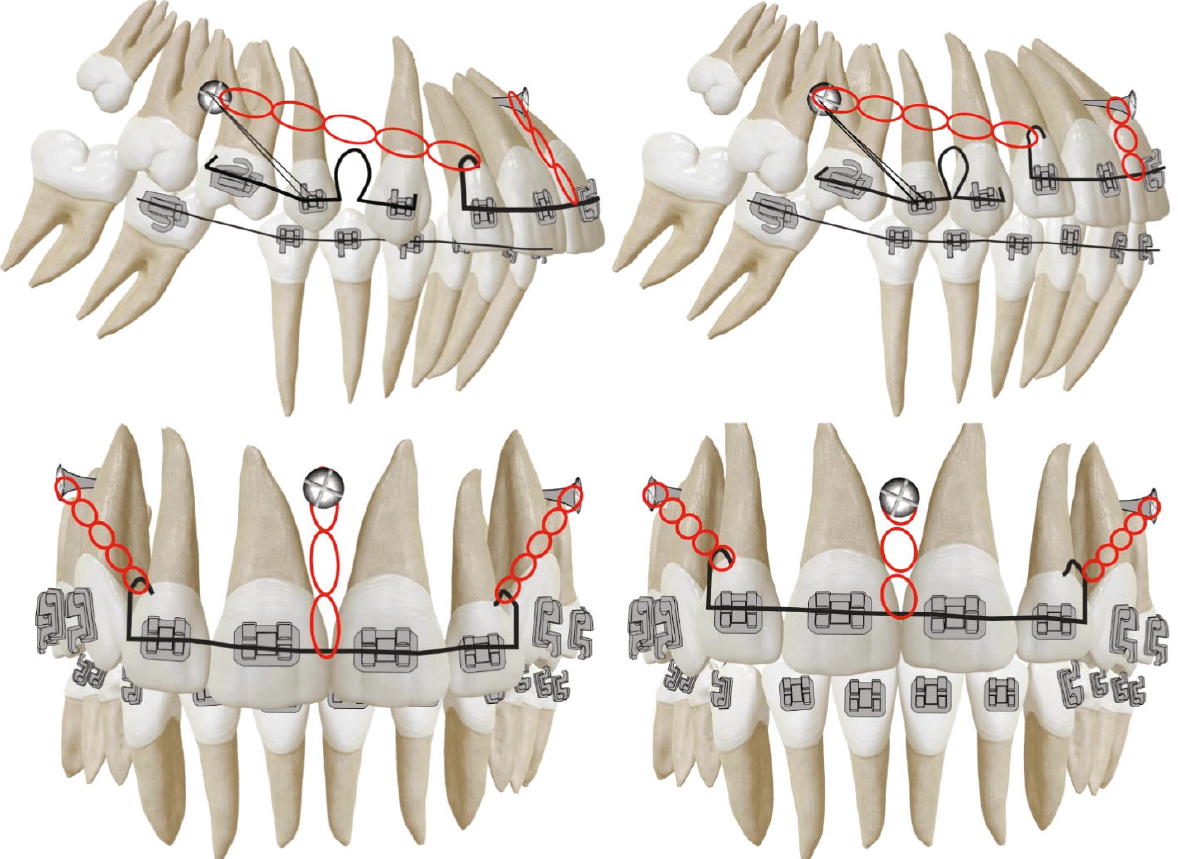
Figure 3: Biomechanical setup for canine retraction and simultaneous anterior retraction and intrusion. TADs placed between upper second premolar and fi rst molars and also between upper central incisors. Sectioned 0 : 019 ″ × 0 : 025 ″ SS archwires anteriorly and posteriorly.